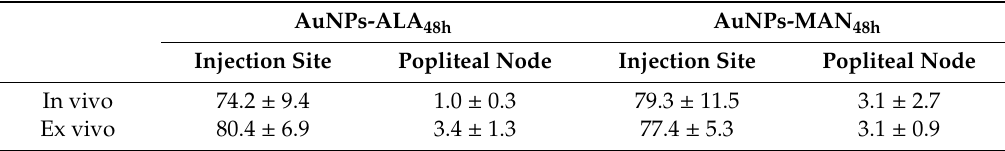
Values represent the average ± SD from n = 3. Values were corrected by radioactive decay.